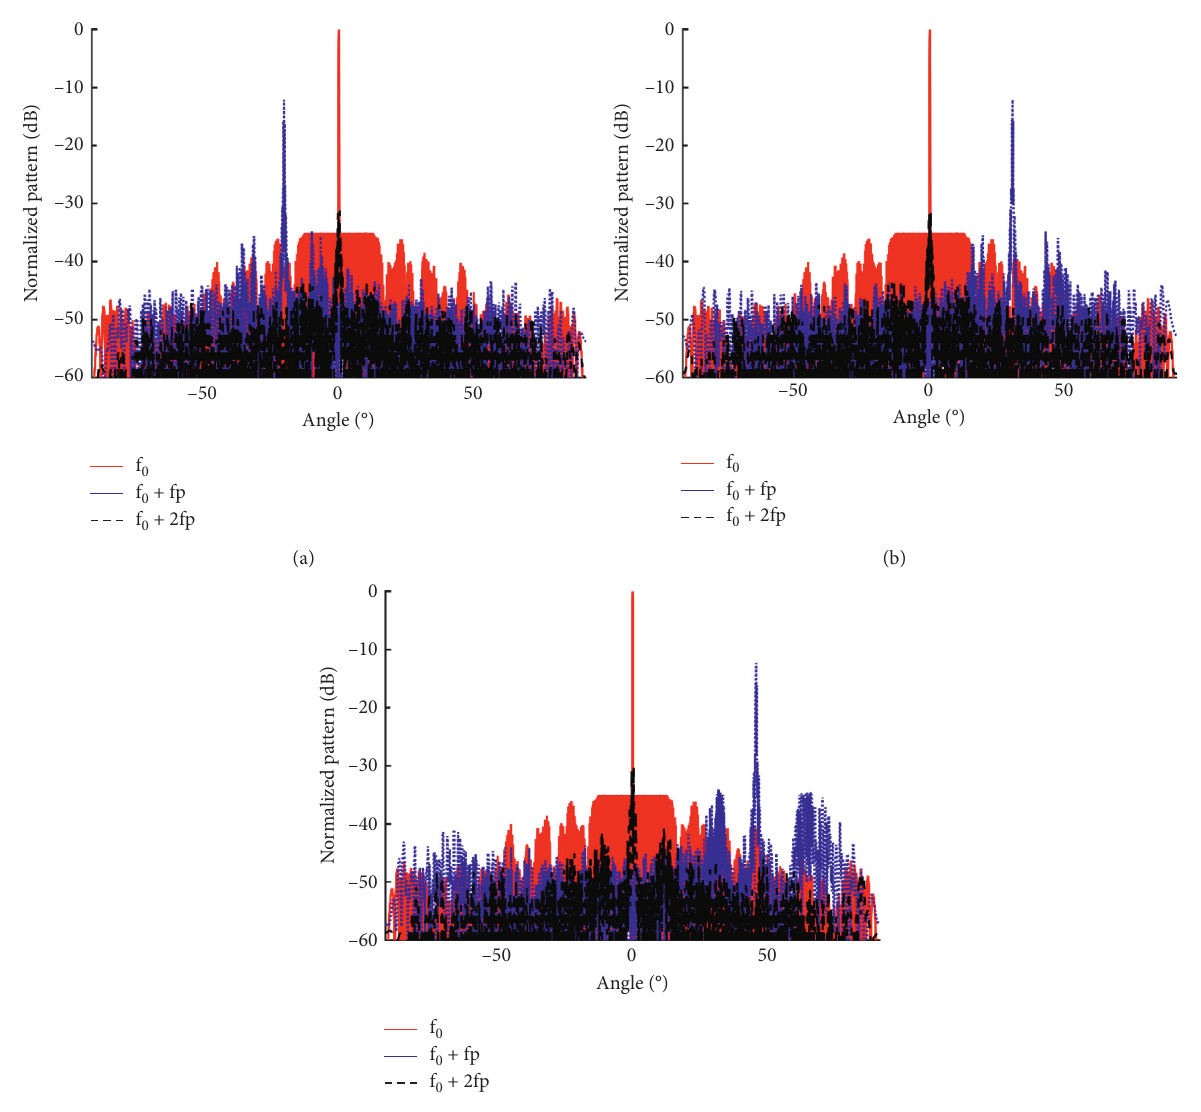
Figure 10: Optimization patterns of different beamforming directions: (a) θ